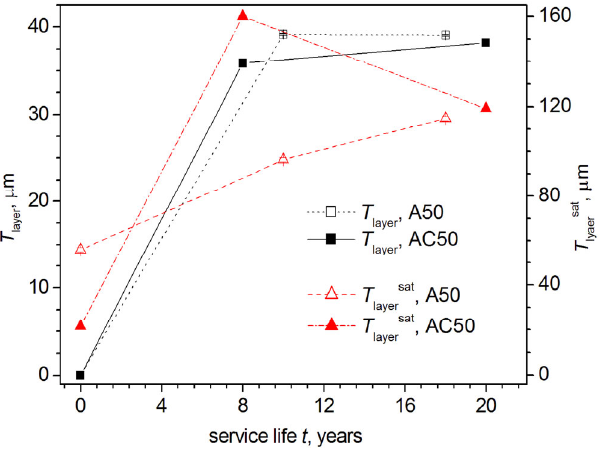
Figure 16. Comparison of dependences of thicknesses of the NSDLs, at which there is a ~50–70% ( T layer ) and ~99% ( T layersat ) drop in XRD mass density, on the service life t of the wires from the overhead power line cables of A50 and AC50 types (respectively, without and with steel